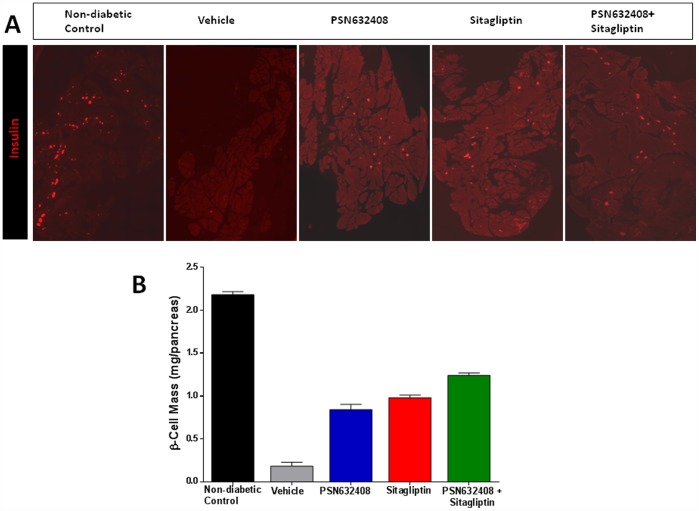
(A) Confocal images represent insulin (red) immunostained pancreas sections from diabetic mice treated with vehicle, PSN632408, sitagliptin, or PSN632408 plus sitagliptin.
(B) Quantification of β-cell mass in the pancreases of non-diabetic control mice and diabetic mice with restored normoglycemia after 7 weeks of treatment with PSN632408, sitagliptin, or PSN632408 and sitagliptin combination (3 to 4 mice per group). β-Cell mass was significantly higher in mice treated with PSN632408 and sitagliptin combination than in mice treated with PSN632408 alone or sitagliptin alone (P<0.05).